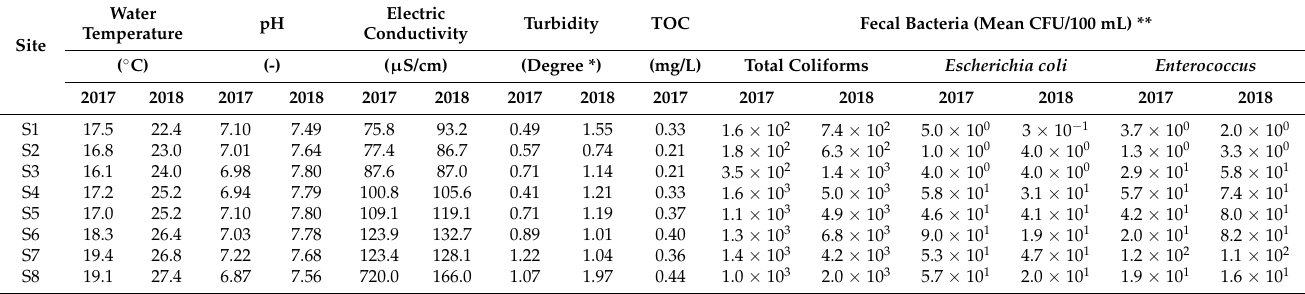
Table 1. Water qualities at each sampling site in 2017 and